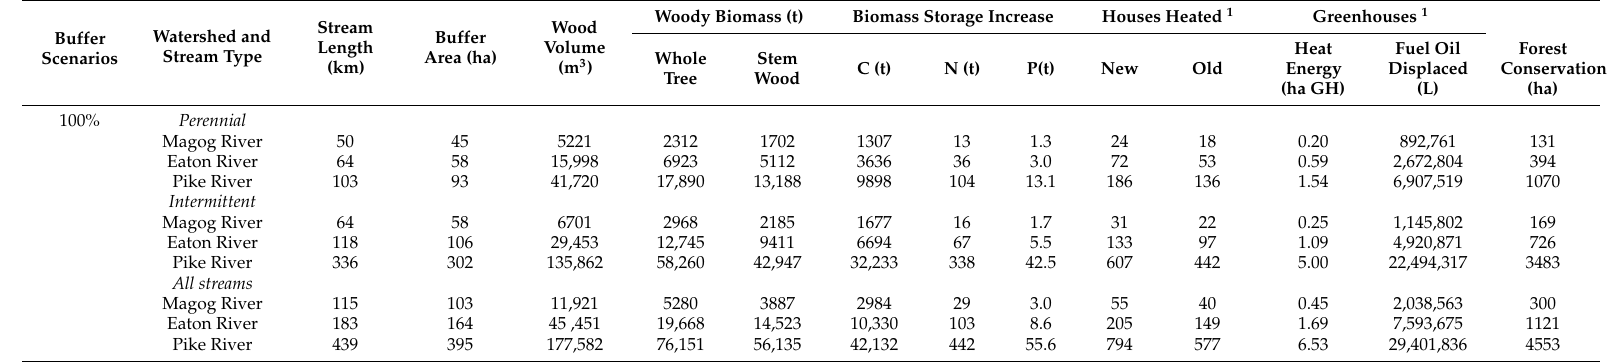
Table 7. Potential ecosystem service provision after 9 years following the replacement of 100%, 25% or 10% of non-managed herbaceous buffers by hybrid poplar buffers along perennial and intermittent streams of the three studied